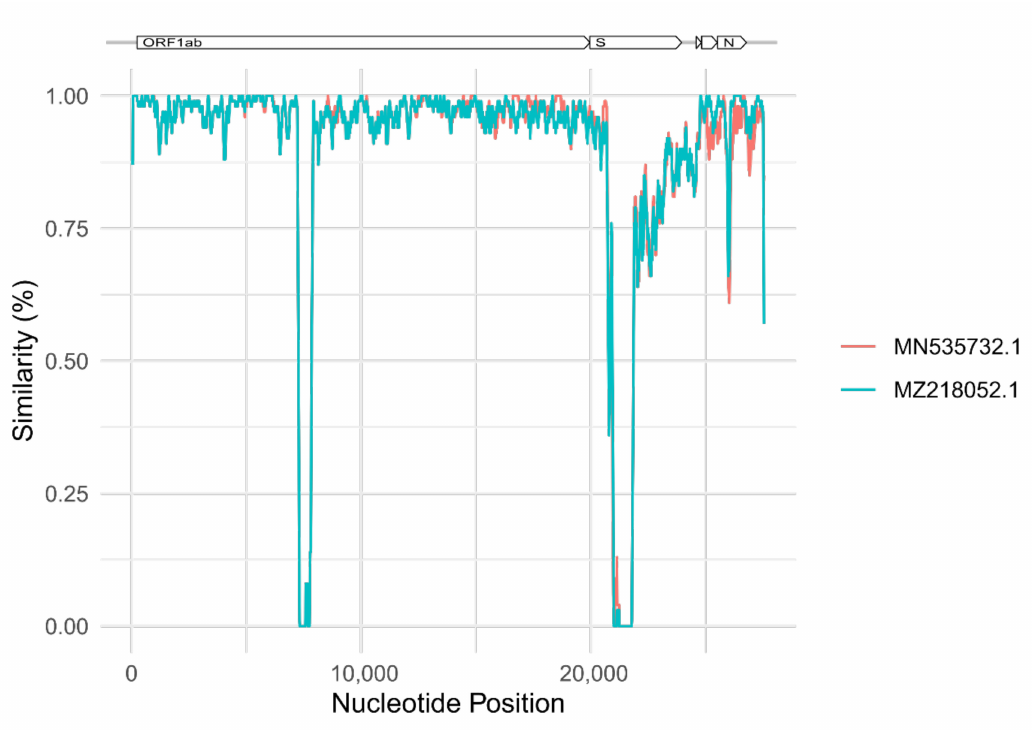
Figure 4. Simplot analysis of OK663601 with the two most closely related viruses (MN535732.1 and